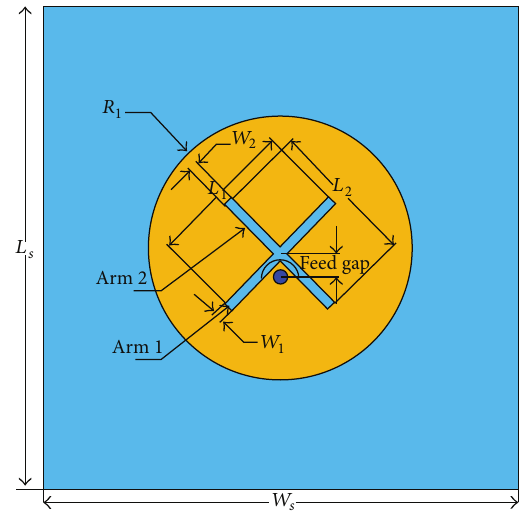
Figure 1: Configuration and parametrized dimensions of the coax- fed dual-band CP